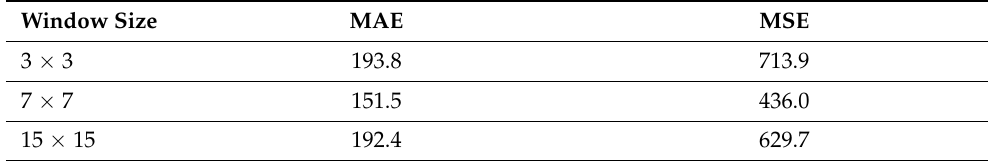
Table 4. The influence of the window size; the measurement indicator is MAE and